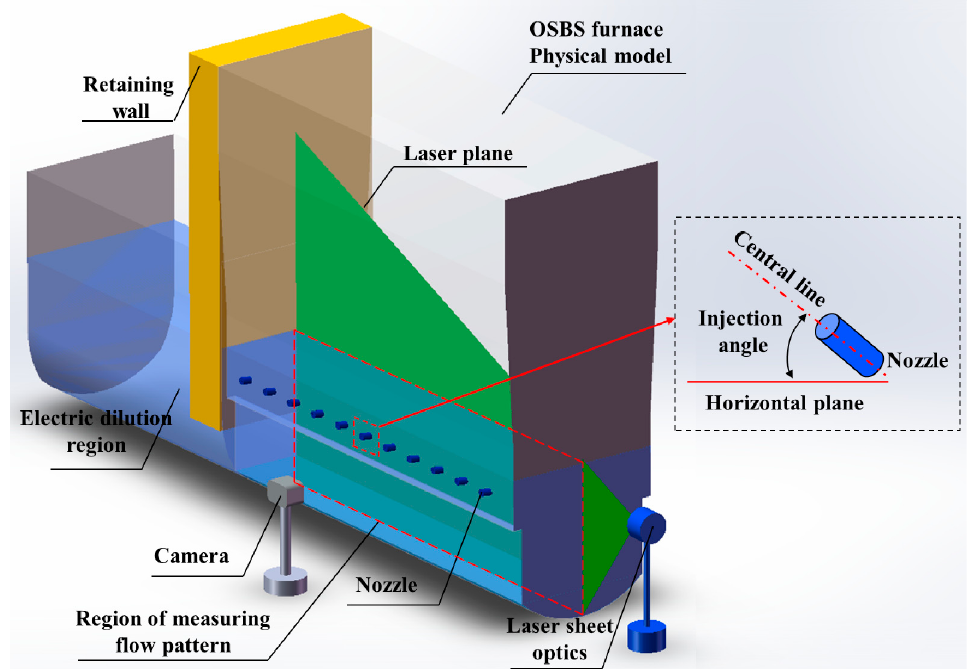
Figure 1. Schematic diagram of the oxygen-rich side-blown bath smelting (OSBS) physical model. Table 1. Dimensions and main parameters of the OSBS furnace and physical model.